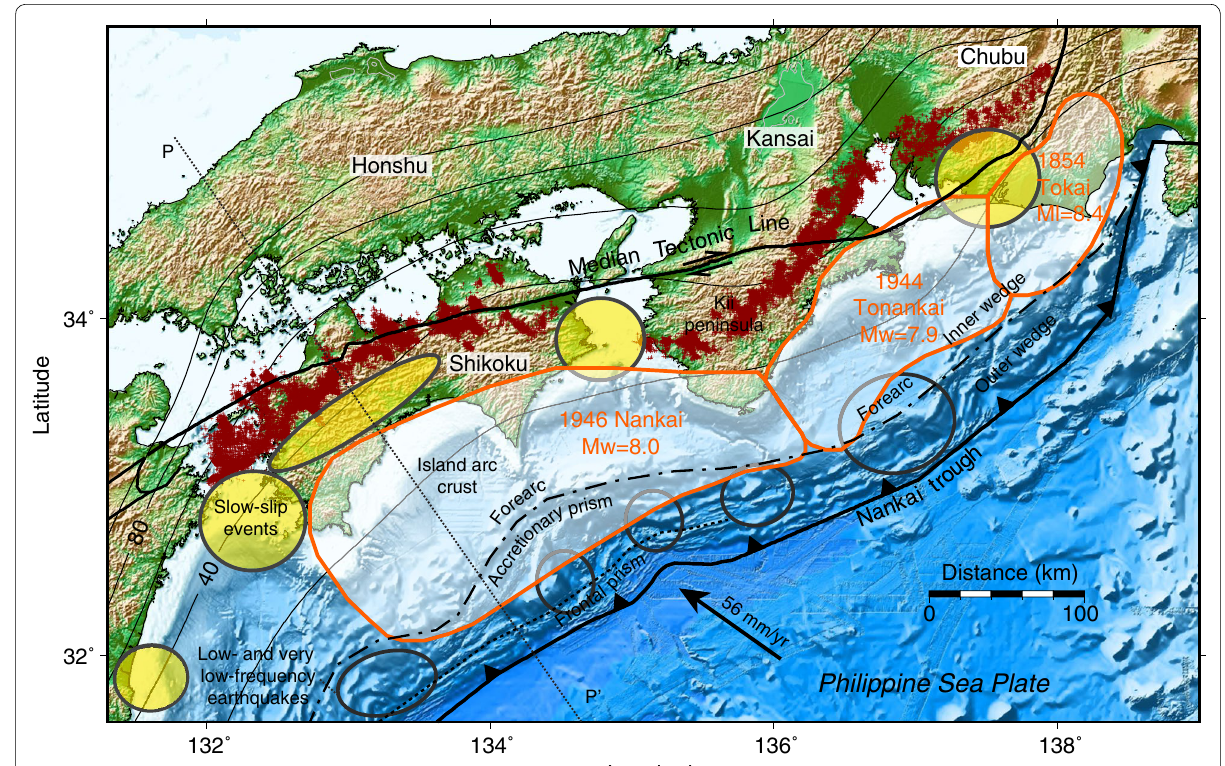
Fig. 1 Down-dip segmentation and the spectrum of slip styles for the Nankai subduction zone. Horizontal projection of the rupture area of the 1854 M L = 8.4 , 1944 M w = 8.1 and 1946 M w = 8.3 earthquakes are outlined by orange contours, which approximately define the along-dip range of the seismogenic zone. Shallow low-frequency earthquakes and very-low-frequency earthquakes are located up-dip to the seismogenic zone. Deep slow-slip events are located down-dip extension of the seismogenic zone. Deep tremors are denoted by dark red dots clustered within a belt-like region down-dip to the deep slow-slip events. The 20-km-interval contours of the depth from 0 to 100 km (Hayes et al. 2018) and trench (thick black toothed lines) depict the geometry of the Philippine Sea slab that is subducting in the direction represented by the black arrow. P-P’ represents a reference profile for the two-dimensional model. The Median Tectonic Line (thick solid line) (Kawamura et al. 2003; Ito et al. 2009) and the landward limit of the accretionary prism (solid-dashed line) (Leggett et al. 1985; Kodaira et al. 2000; Takahashi et al. 2003) are the surface expression of the material boundaries shown in Fig. 11. The spatial distribution of deep tremors is from Maeda and Obara (2009) and Obara et al. (2010); great earthquakes, slow-slip events and shallow low-frequency earthquakes from Obara and Kato